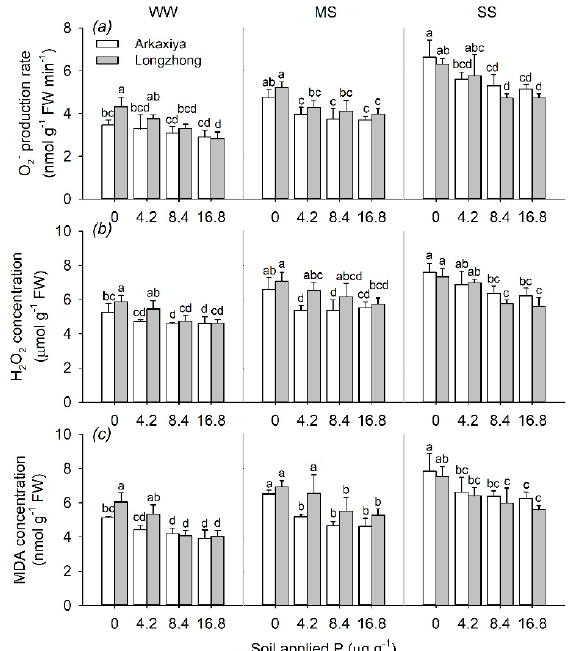
Figure 5. Production rate of reactive oxygen species (O 2 − ) ( a ), hydrogen peroxide concentration (H 2 O 2 ) ( b ) and malondialdehyde (MDA) concentration ( c ) per gram fresh weight (FW) of leaves of two alfalfa genotypes, Arkaxiya (white bars) and Longzhong (grey bars), grown for 10 weeks with four P supply levels and three water treatments: (i) well-watered (WW); (ii) moderate water shortage (MS); and (iii) severe water shortage (SS). Values are means + one standard error of the mean ( n = 3). Different letters between bars represent significant differences between means at p < 0.05.